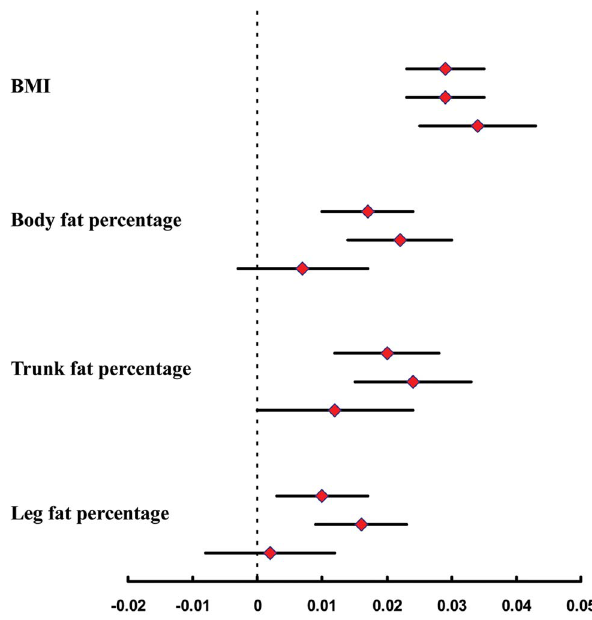
Figure 2. The associations of overall GRS, EA GRS and EAA GRS with adiposity traits. Figure shows the effects of overall GRS (top estimate), EA GRS (middle estimate), and EAA GRS (bottom estimate) on inverse normal transformed BMI, body fat percentage, trunk fat percentage, and leg fat percentage in our population. people with high physical activity (beta = 0.08 kg/m 2 per allele; P = 0.004) compared to those with low PA (beta = 0.20 kg/m 2 per allele; P = 0.009) (Table 4). The interaction effects were similar for the EA GRS (beta interaction = 2 0.05 kg/m 2 ; P = 0.13) and EAA